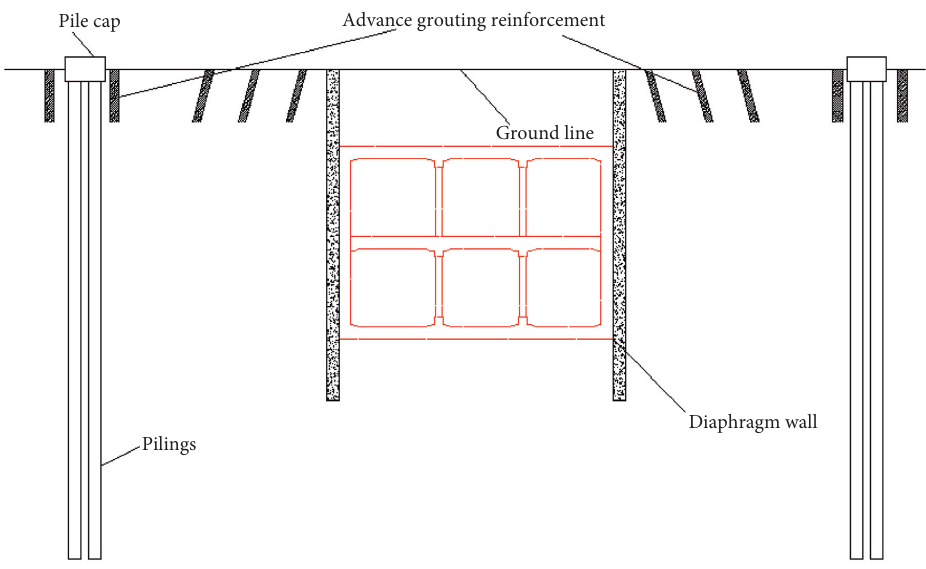
Figure 7: Ground grouting measures.